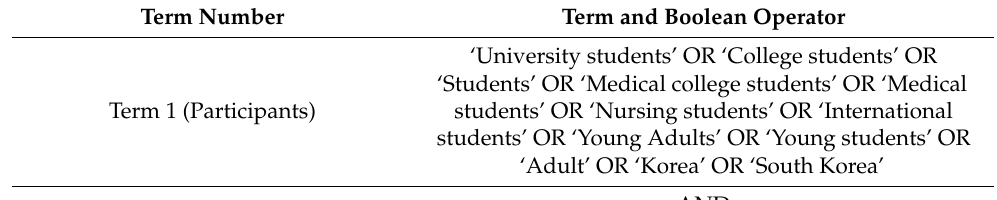
Table 1. Search terms and linkage for the